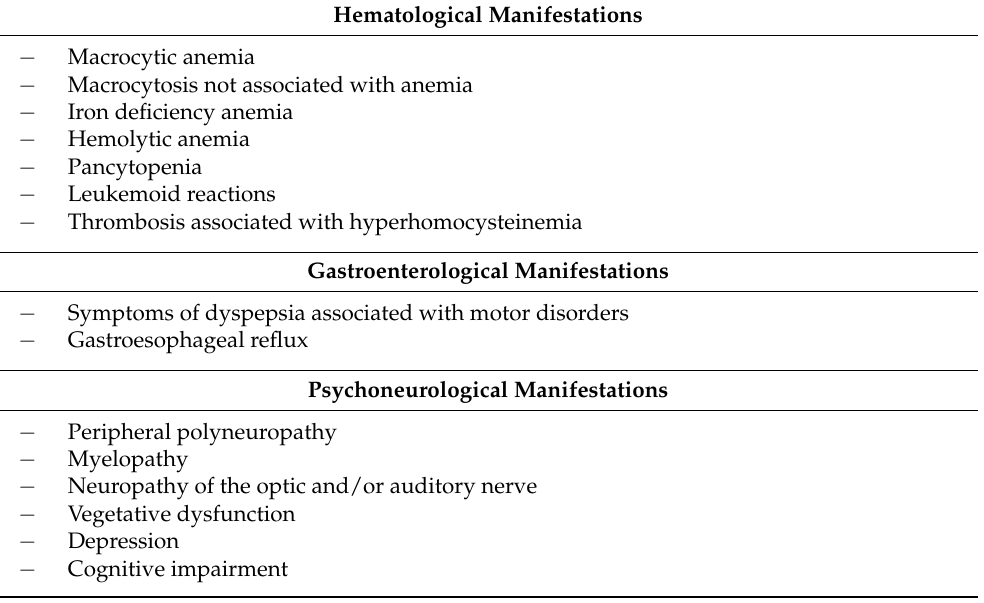
Table 1. The main clinical manifestations of autoimmune gastritis (adapted from Massironi et al.,